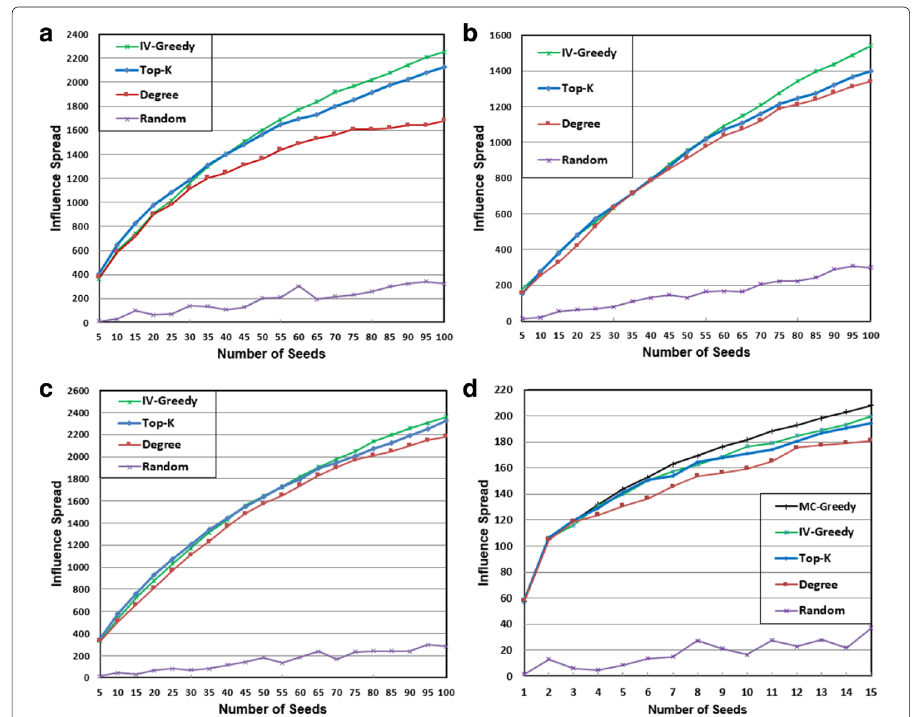
Fig. 1 Performance comparison on influence spread. a PGP dataset, b NetHEPT dataset, c WikiVote dataset, and d C.elegans dataset